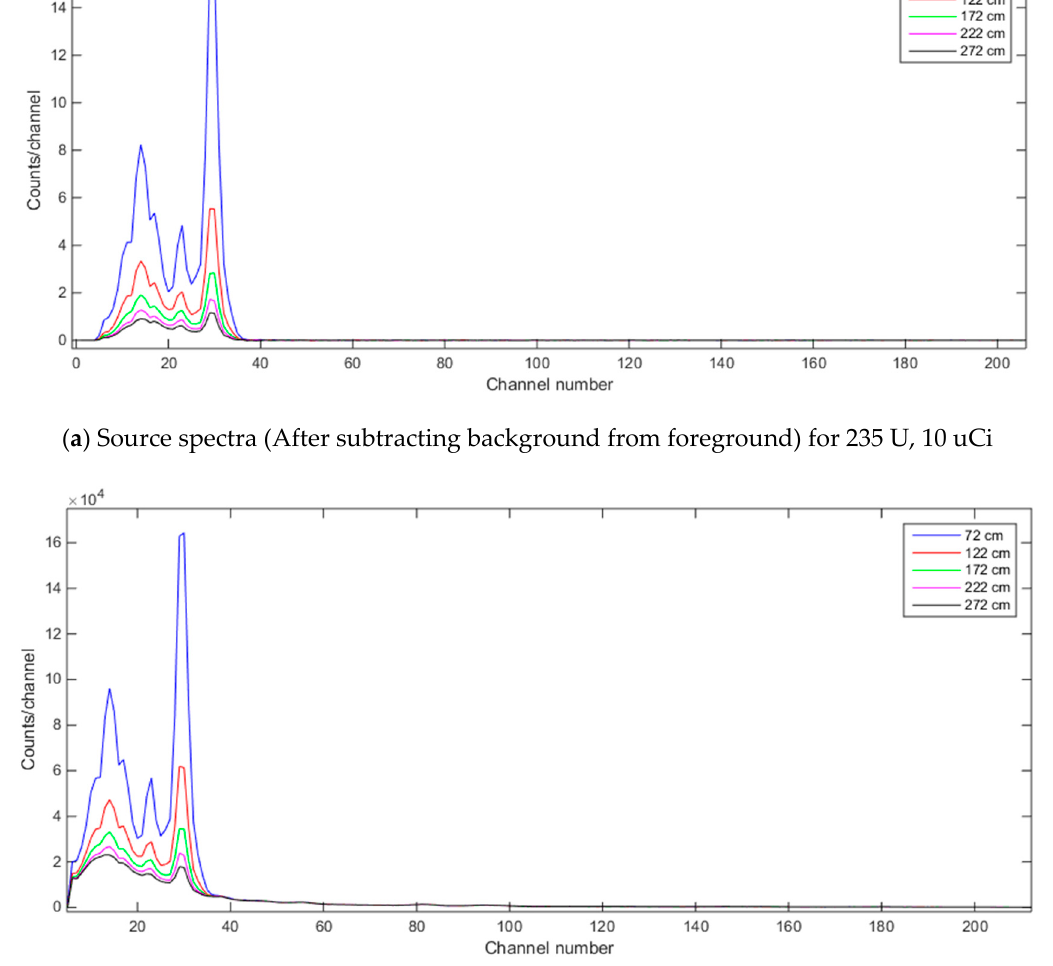
Figure 14. Foreground and source spectra for 235 U, 10 uCi when source ‐ to ‐ detector distance varies (NaI detector where detector ‐ to ‐ ground distance is set to 56 cm and dwell time for detector is 3600 s).